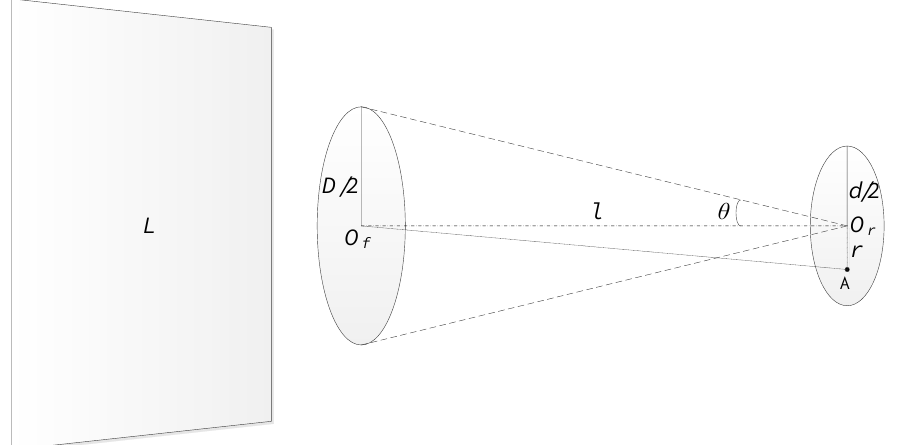
Figure 1. Schematic of radiance measurement.